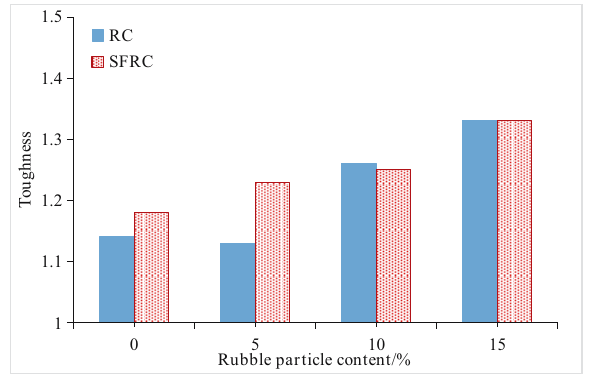
Figure 14: Toughness index of di ff erent concrete mix